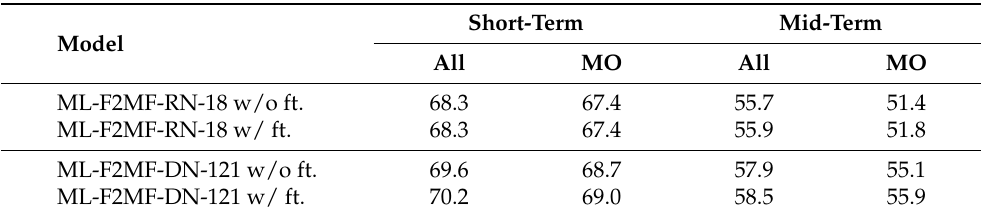
Table 6. Validation of upsampling path fine-tuning for semantic segmentation